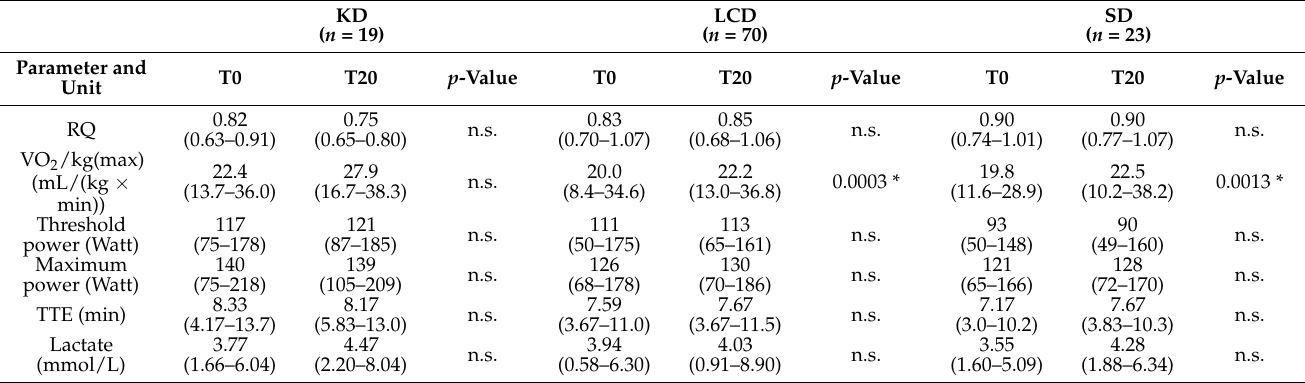
Table 2. Performance parameters at start and end of